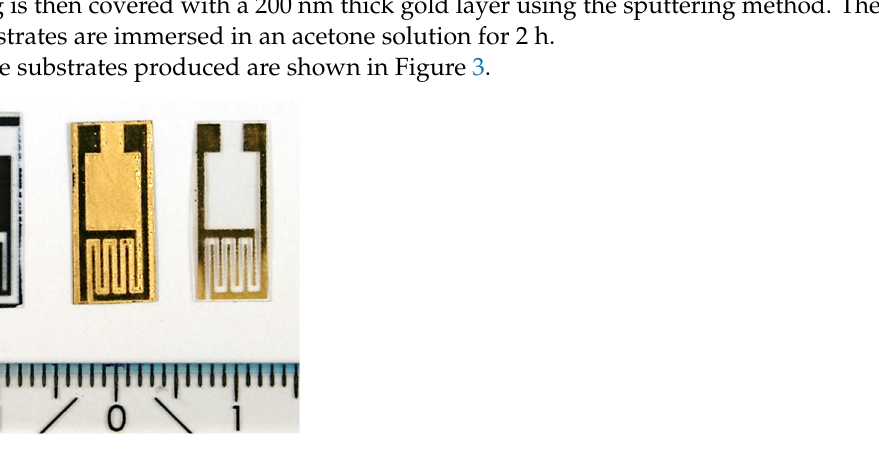
Figure 3. Substrates samples, from left to right, after printing: after gold deposit: after ink acetone removal (measurement scale in centimeters).